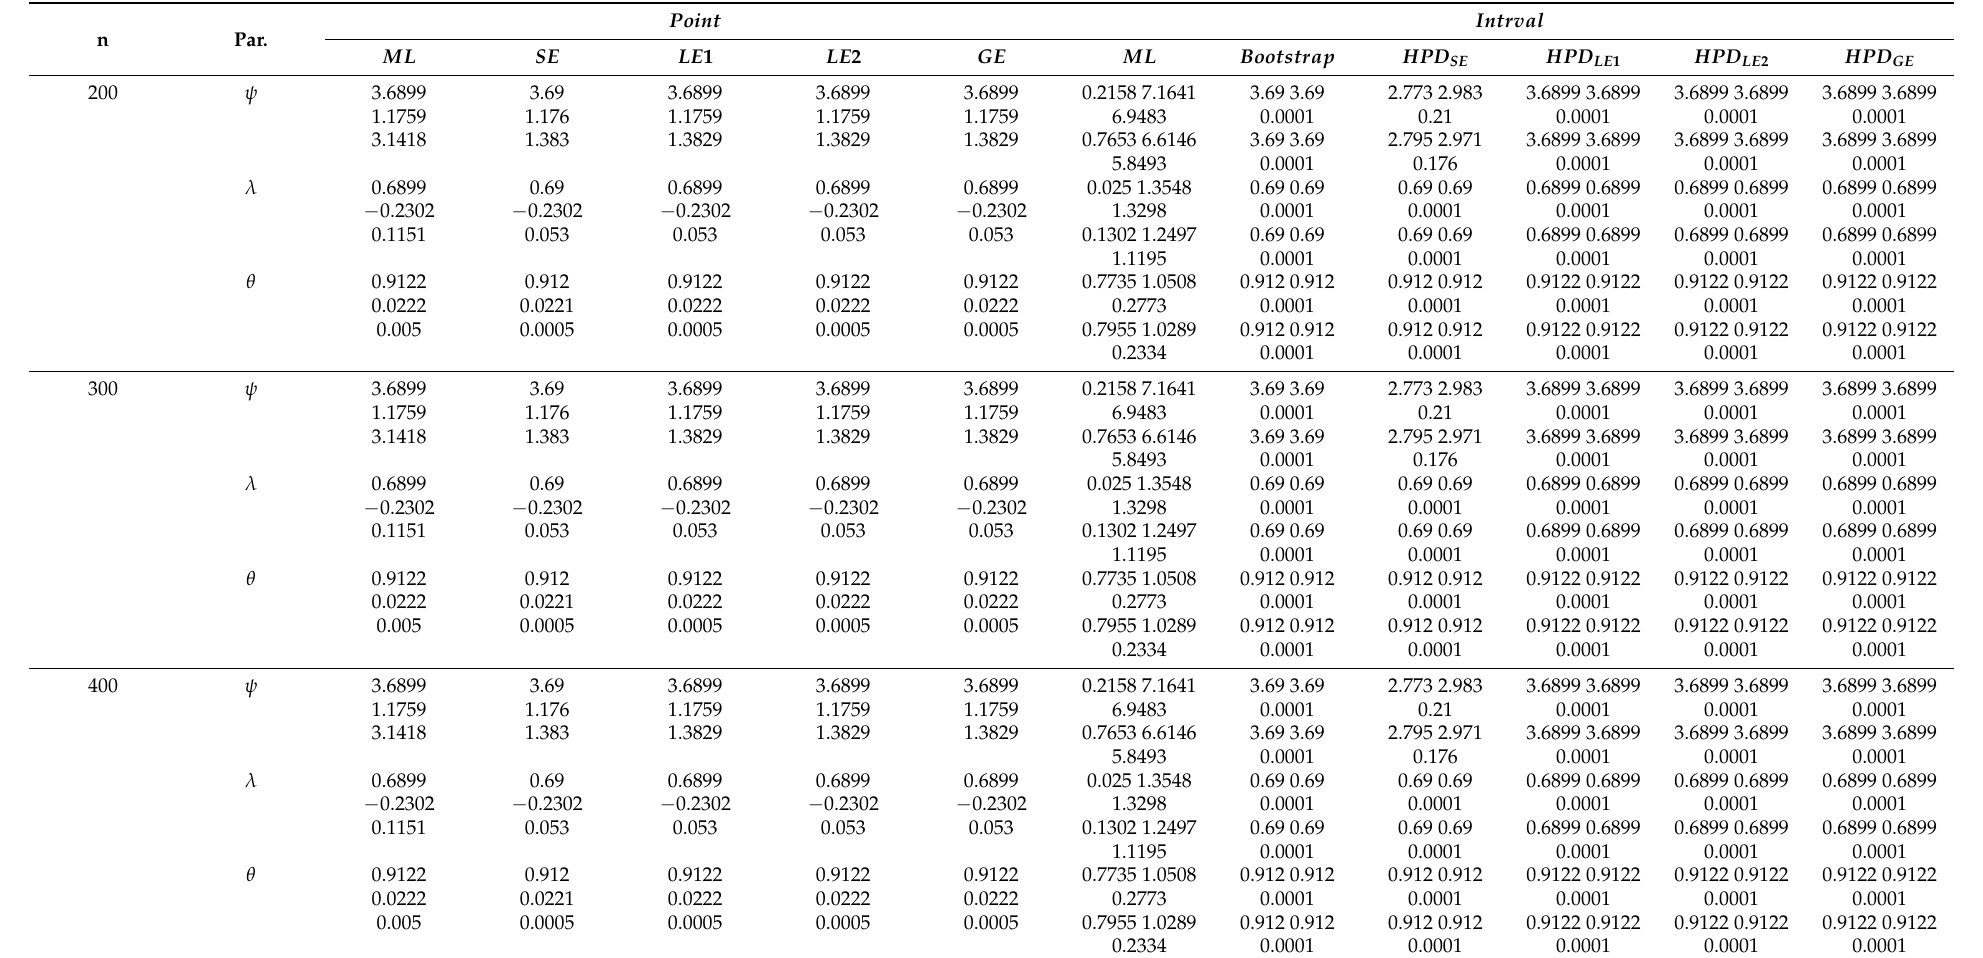
Point estimate: first, second, and third lines represent estimate, baises and ER, respectively. Interval estimate: 95% and 90% interval estimate, respectively. The first and second lines show the credible HPD interval and the corresponding width of the parameter,